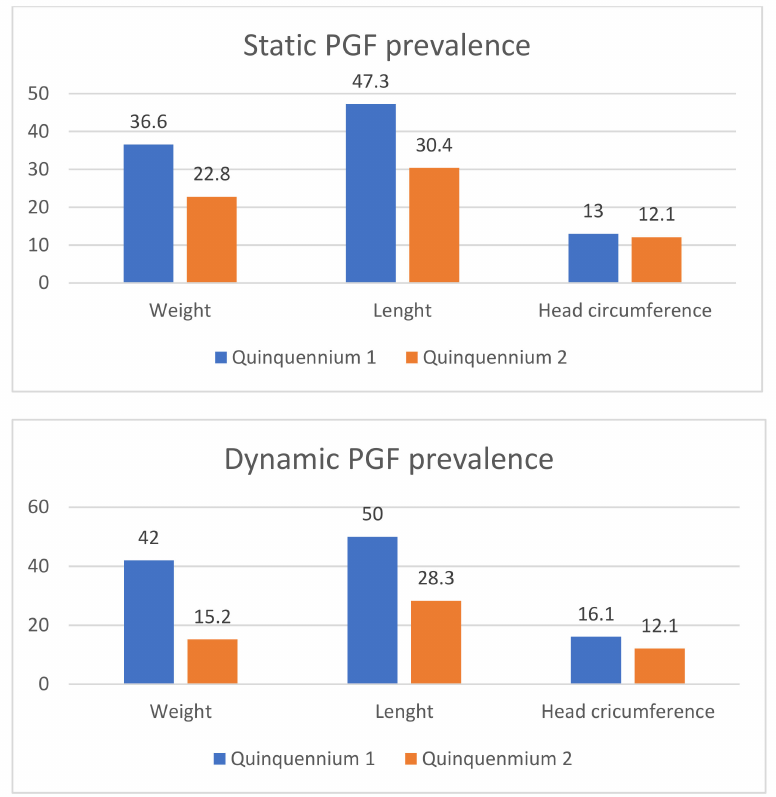
Figure 2. Changes in prevalence of static and dynamic postnatal growth faltering (PGF)